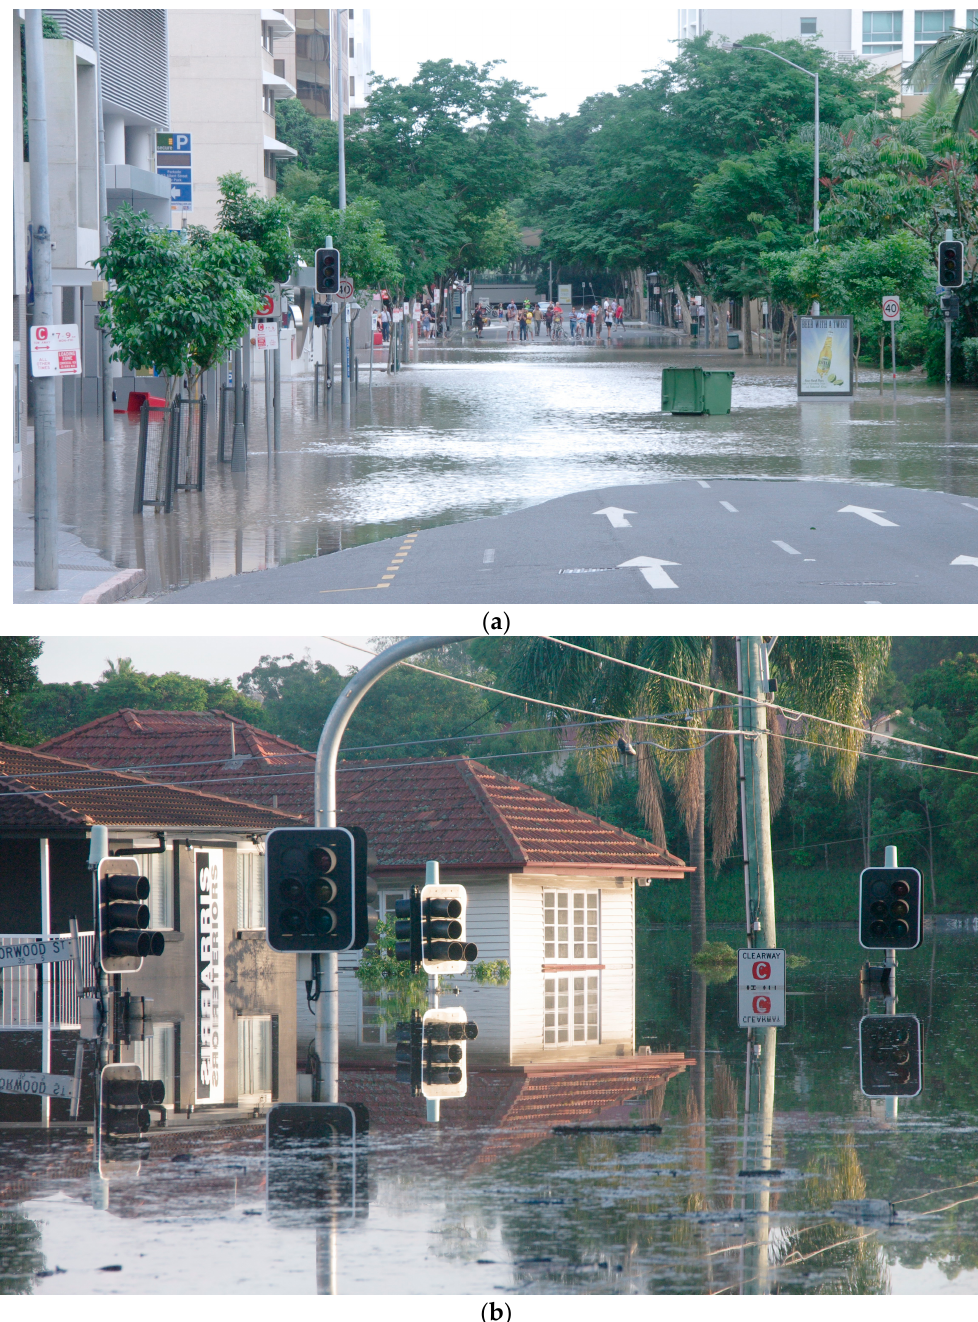
Figure 3. Inner city of Brisbane, Australia during the 2011 Brisbane River flood inundation. ( a ) Intersection of Margaret and Albert Streets on 12 January 2011 at 16:30. ( b ) Submerged intersection of Milton Road and Eagle Terrace on 13 January 2011 at 05:35.